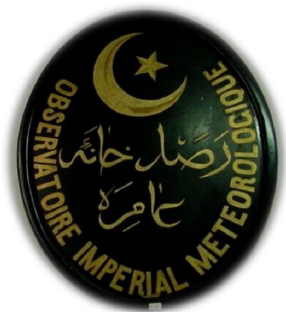
Figure 2. Emblem of the Rasathane-i Amire (Imperial Meteorolog- ical Observatory).